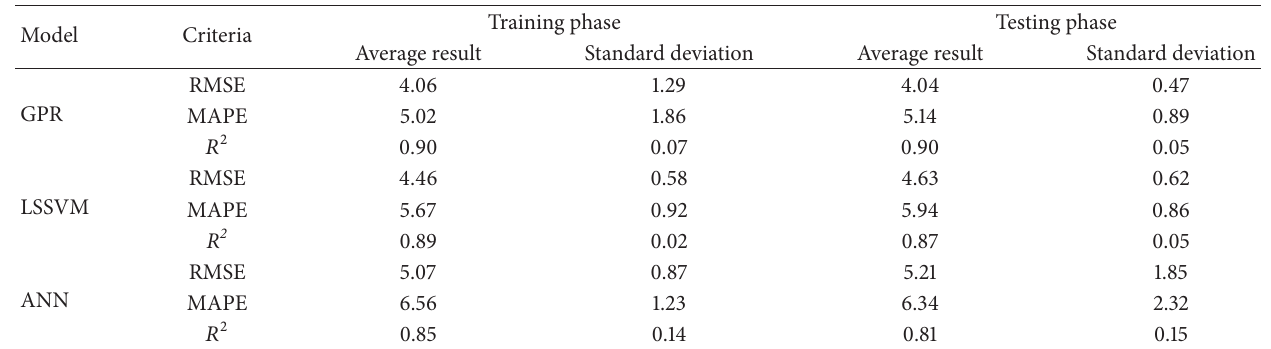
Figure 3: GPR prediction result obtained from the 10-fold cross validation. Table 2: Prediction result